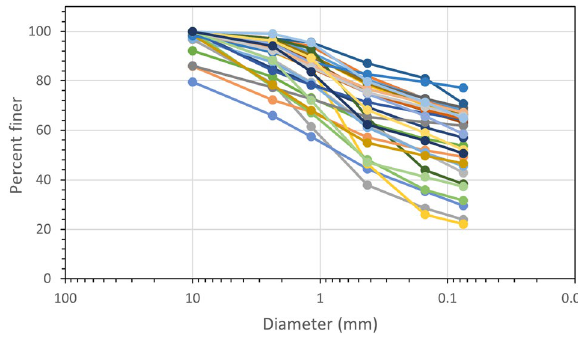
Figure. 5. Grain size distribution curve.